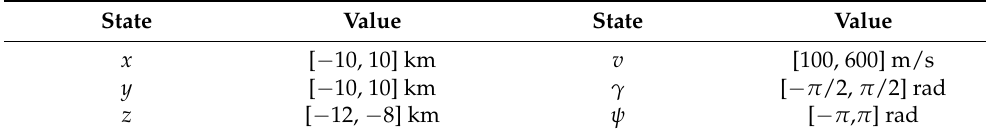
Table 4. Initial states setting.